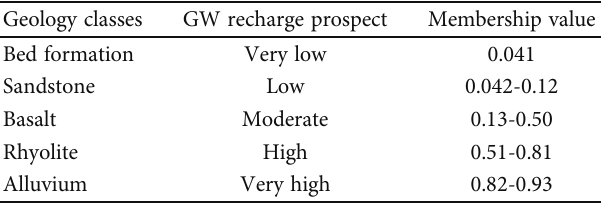
Table 4: Geology classes, membership value, and distribution. Geology classes GW recharge